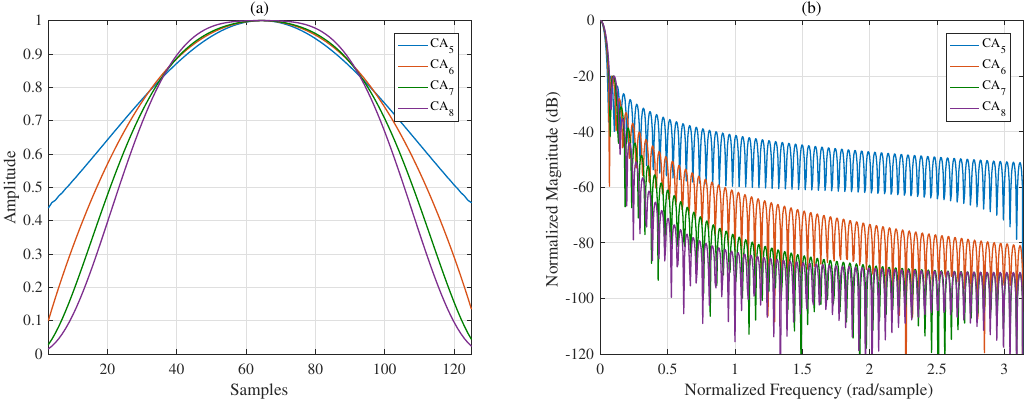
Figure 2. Windows with different SLFORs ( a ) in the time domain and ( b ) in the frequency